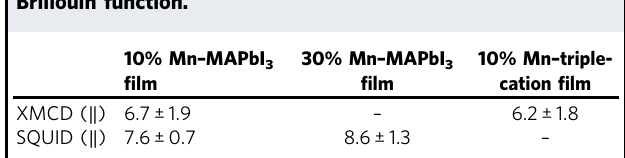
Table 1 Curie-Weiss temperatures (in K) extracted from temperature-dependent data fi tted with the Curie – Weiss